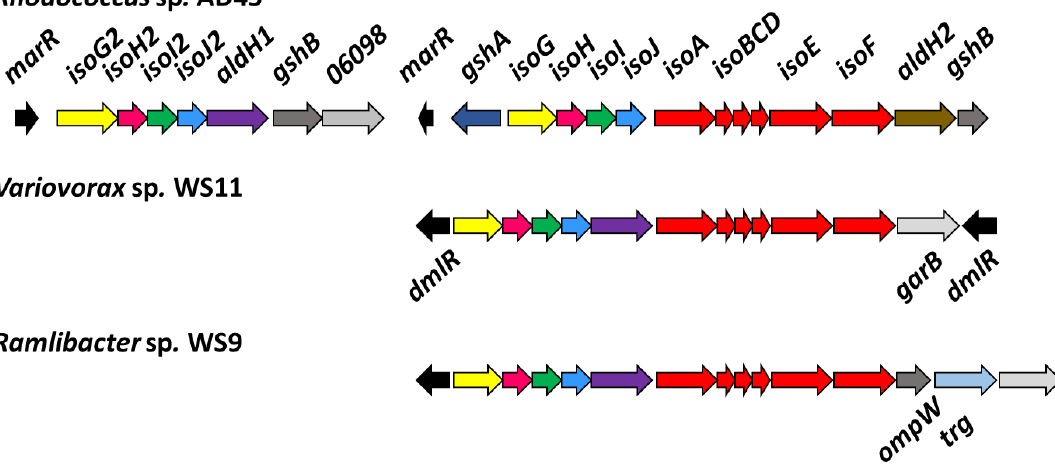
Figure 1. Comparison of iso metabolic gene cluster organisation of the reference isoprene degrader Rhodococcus sp. AD45 with Variovorax sp. WS11 and Ramlibacter sp. WS9.